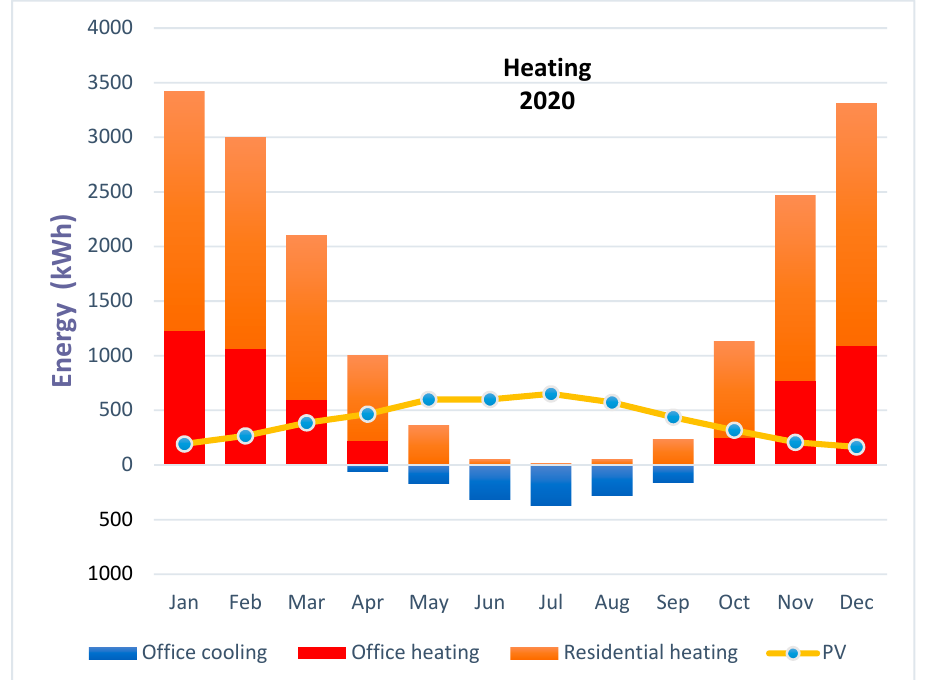
Figure 4. Simulated heating (positive) and cooling (negative) energy demand in the neighbourhood for office and residential buildings. The energy generated by photovoltaic (PV) surfaces using the rooftops of public buildings in the neighbourhood is also shown.